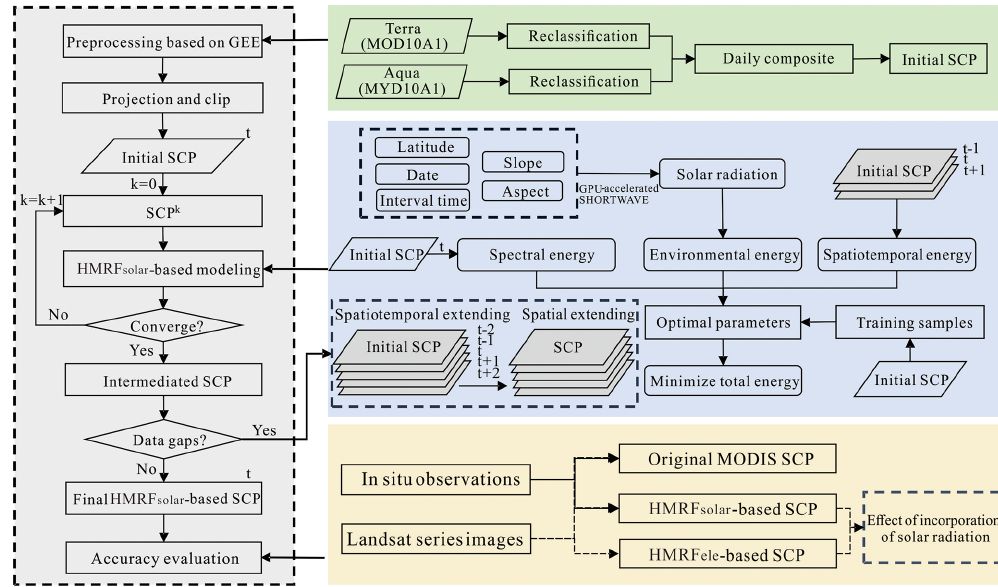
Figure 3. Overall flowchart of the HMRF solar -based framework. (SCP stands for snow cover products.)